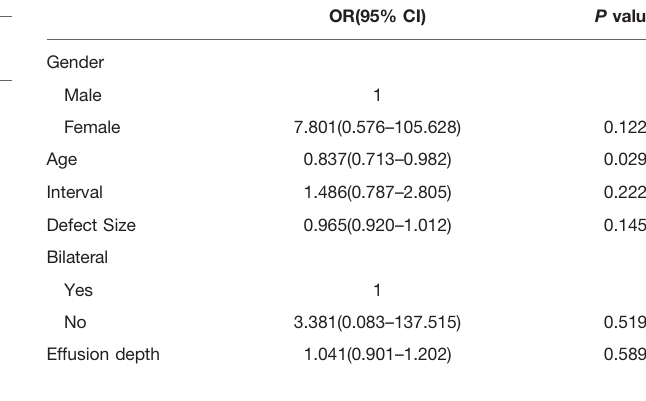
TABLE 4 | Binary logistic regression analysis for factors associated with brain midline shift in the PEEK cranioplasty